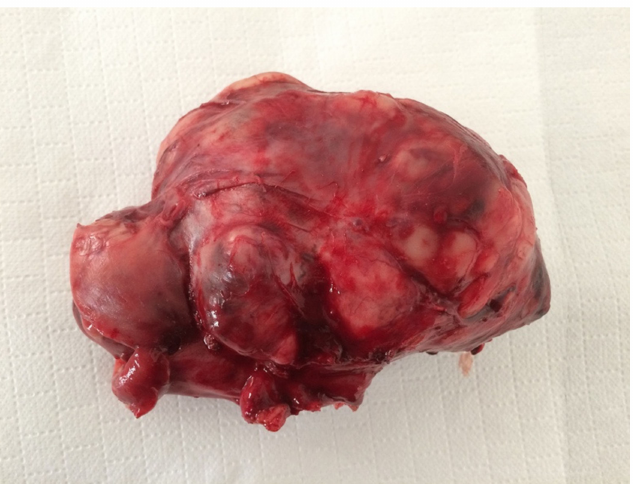
Figure 4. Female neutered crossbred, 14 years old. Intra-abdominal sarcoma, 10 cm in diameter, without connection with any